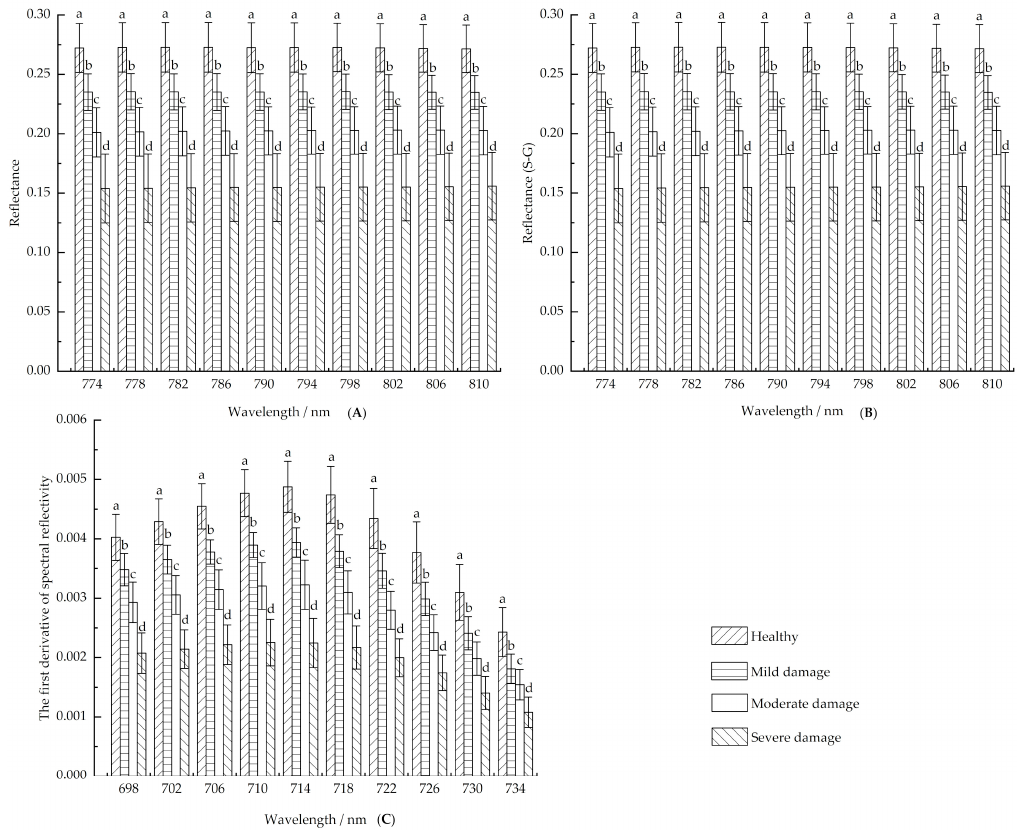
Figure 9. Results of the one-way ANOVA of the wavelengths. ( A ) The original spectra. ( B ) The S-G spectra. ( C ) The first derivative. The data are presented as the mean ± standard error, a, b, c and d indicate that the damage degree is significantly different at this band ( p < 0.05), while the same letter indicates that there is no significant difference.